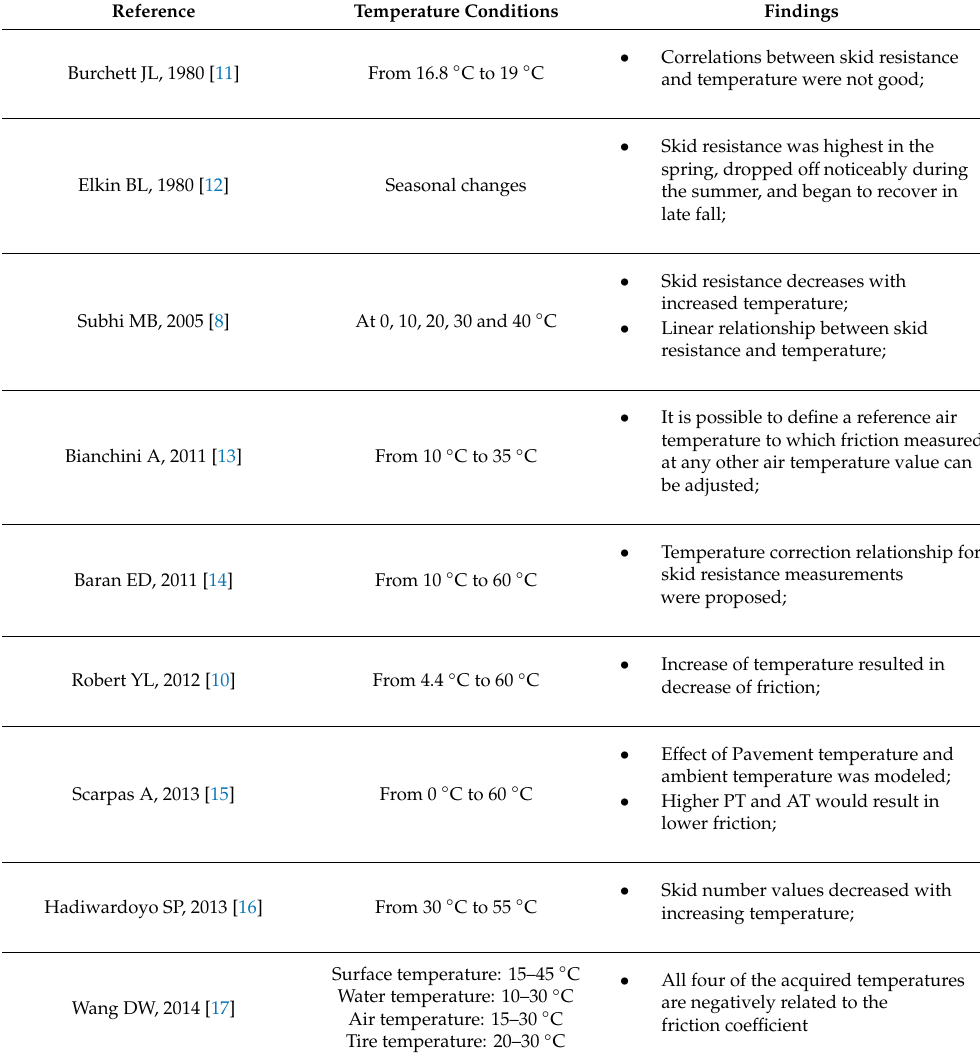
Table 1. Temperature e ff ect on the friction behavior from